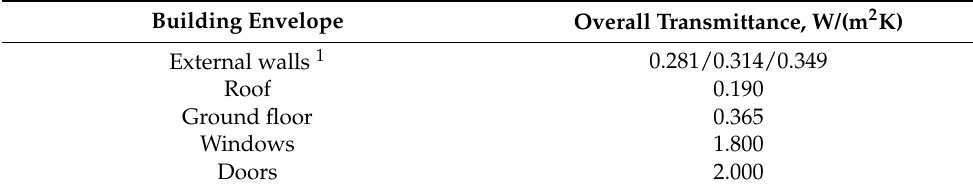
Table 3. Thermal characteristics of the building envelope.